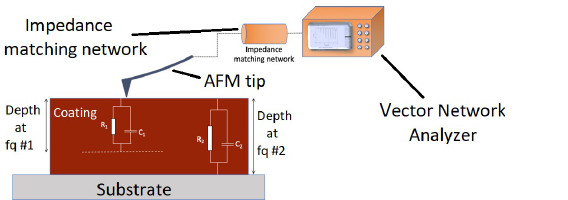
Figure 1. Scanning Microwave